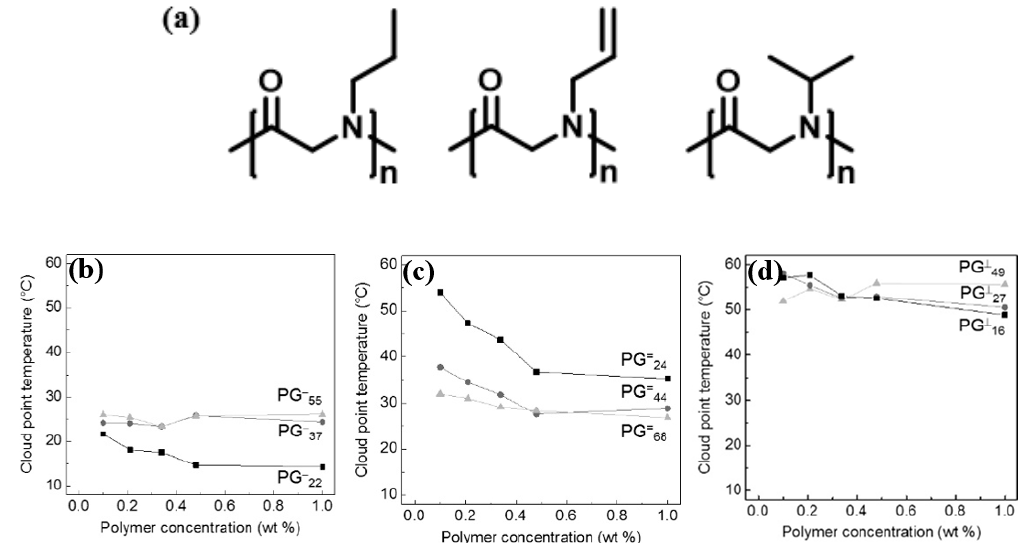
Figure 2. ( a ) Thermoresponsive polypeptoid homopolymers poly( N -C3 glycine)s. Plots of the cloud point temperatures versus concentration: poly( N -C3 glycine)s , ( b ) C3 = n -propyl (PG ─ n , n = 22, 37, and 55), ( c ) allyl (PG ═ n , n = 24, 44, and 68), and ( d ) isopropyl (PG ┴ n , n = 16, 27, and 49) reprinted with permission from [53] . Copyright 2013, American Chemical Society.